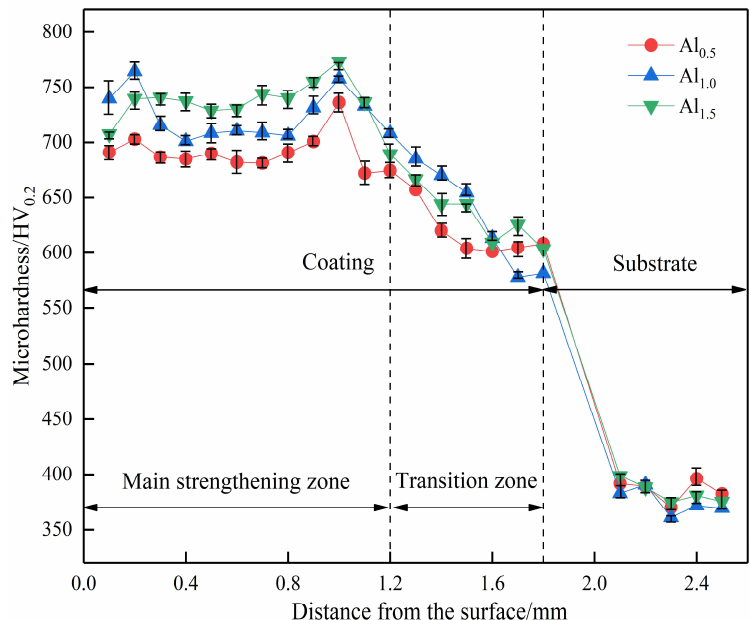
Figure 4. Microhardness distribution across the cross sections of the coatings.